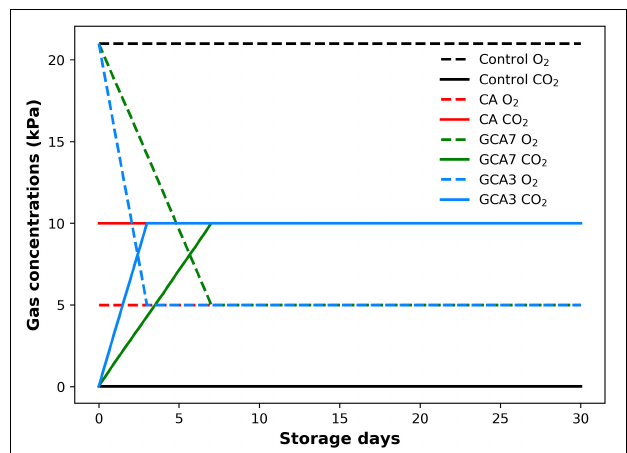
FIGURE 1 | Gas concentration (CO 2 and O 2 ; kPa) supply throughout 28 days of storage at 0 ◦ C and 90–95 RH%; air [control]; standard CA (10